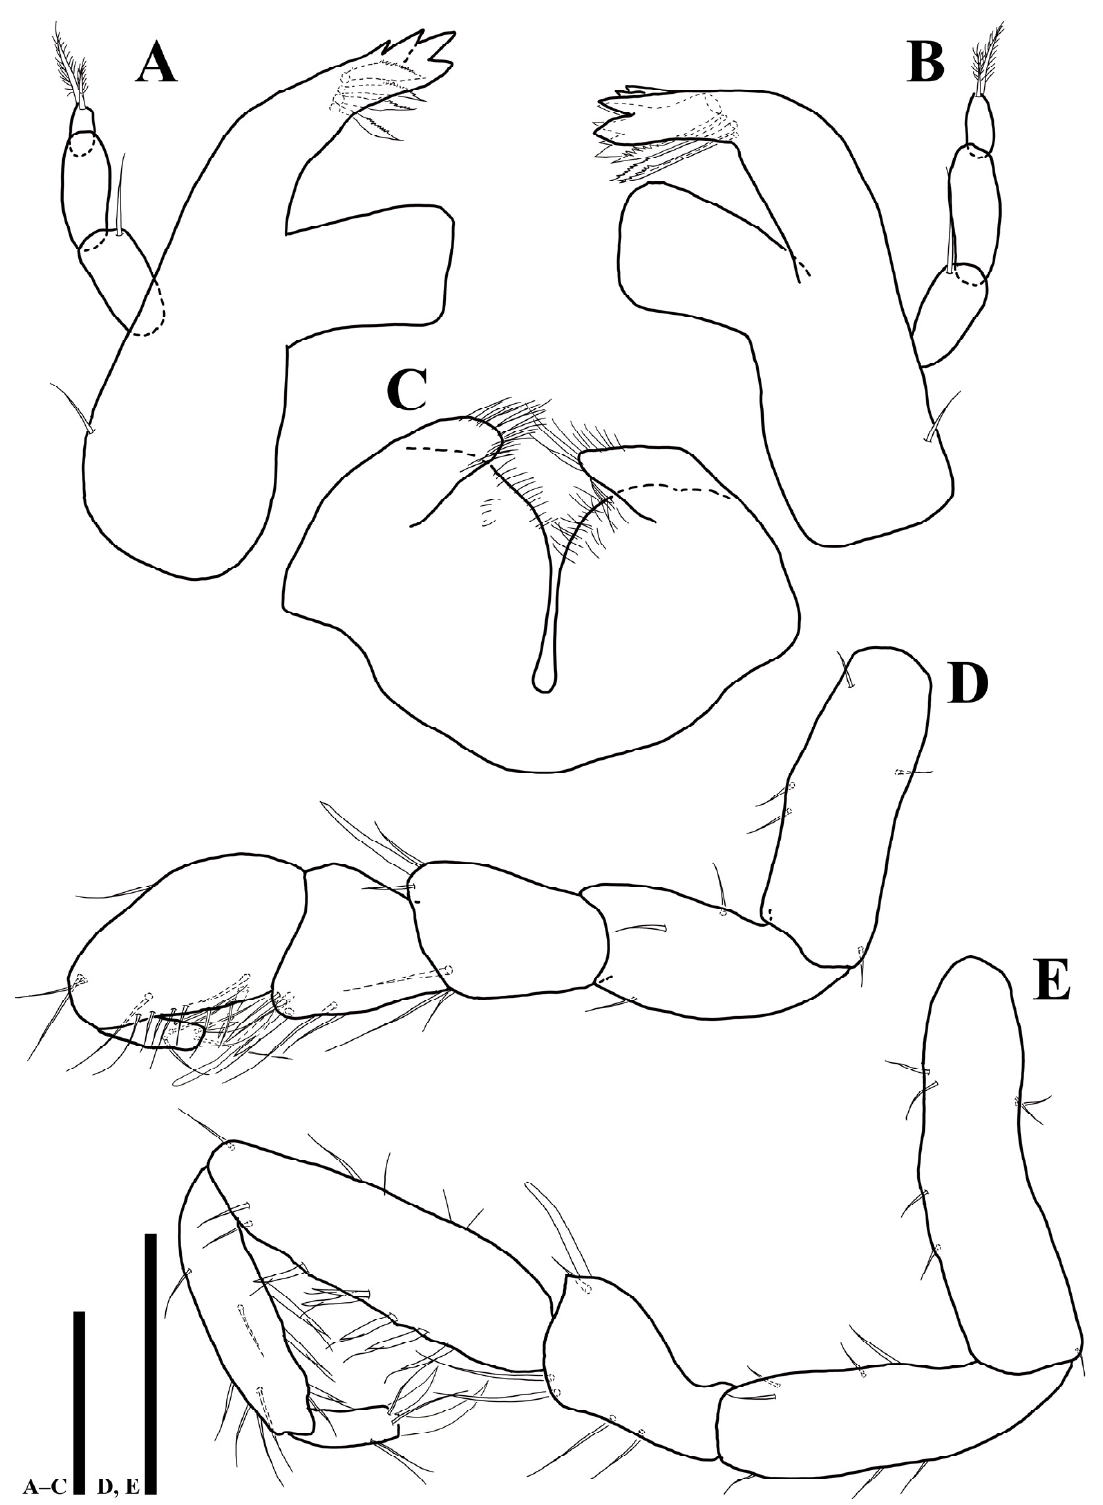
Figure 4. Uromunna mundongensis sp. n. holotype male: ( A ) right mandible; ( B ) left mandible; ( C ) labium; ( D ) pereopod 1; ( E ) maxilla. Scale bars = 50 μ m ( A ‒ C ), 100 μ m ( D , E ).